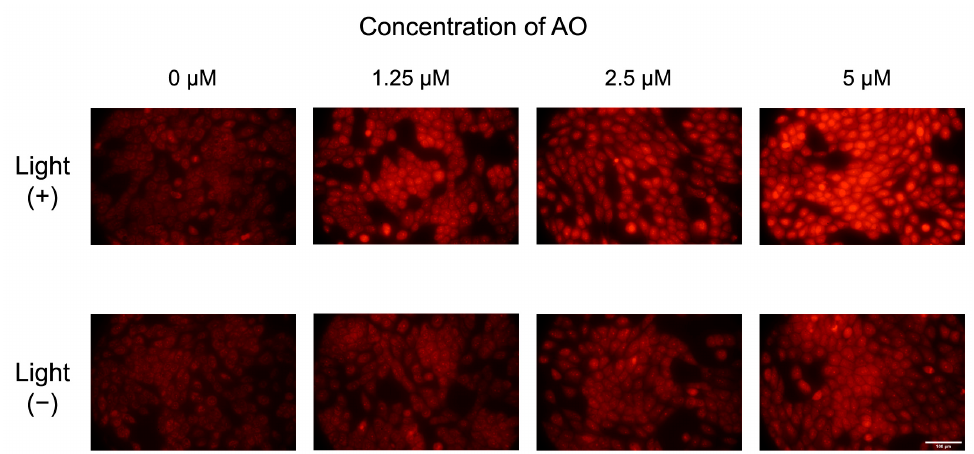
Figure 5. Fluorescence images of MET1 cells in the presence of different concentrations of acridine orange (AO) with the presence or absence of light (457 nm). The light dose applied to the irradiated cells was 2.5 J/cm². Scale bar = 100 µm.